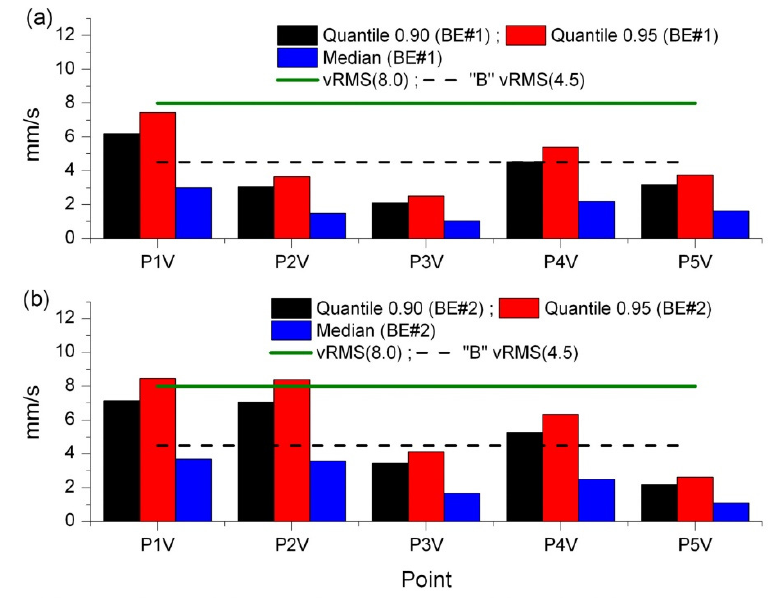
Figure 17. Quantiles of vibration velocity at the measuring points (in the vertical direction) in the tested bucket elevators: ( a ) BE#1 and ( b ) BE#2.